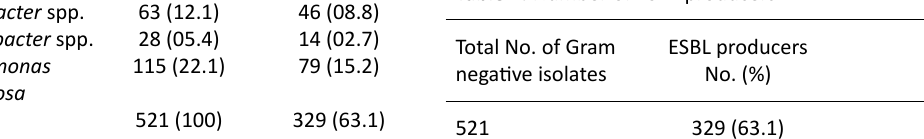
Table 2. Number of ESBL producers